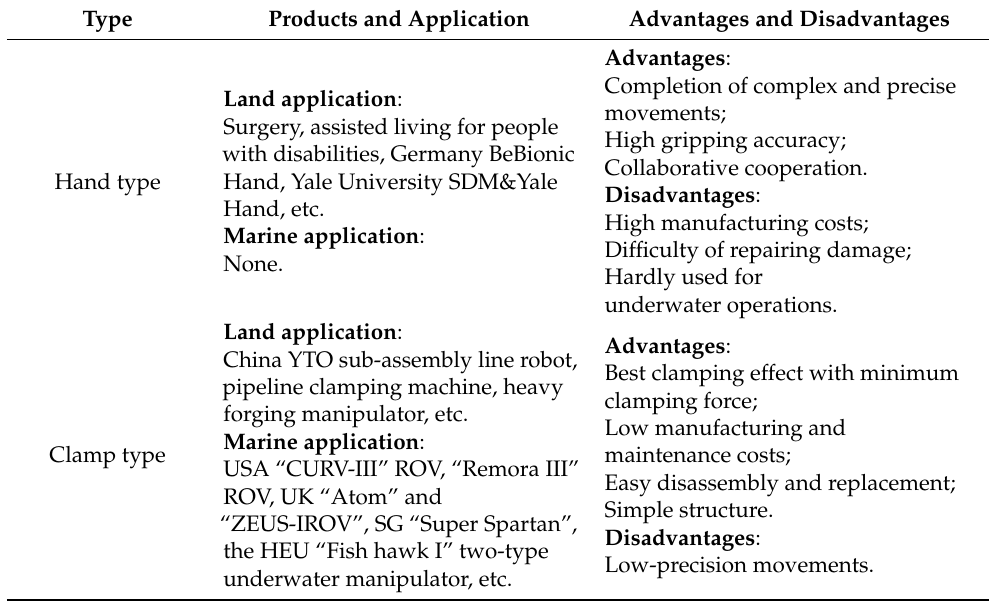
Table 2. Comparison of the two types of manipulators.